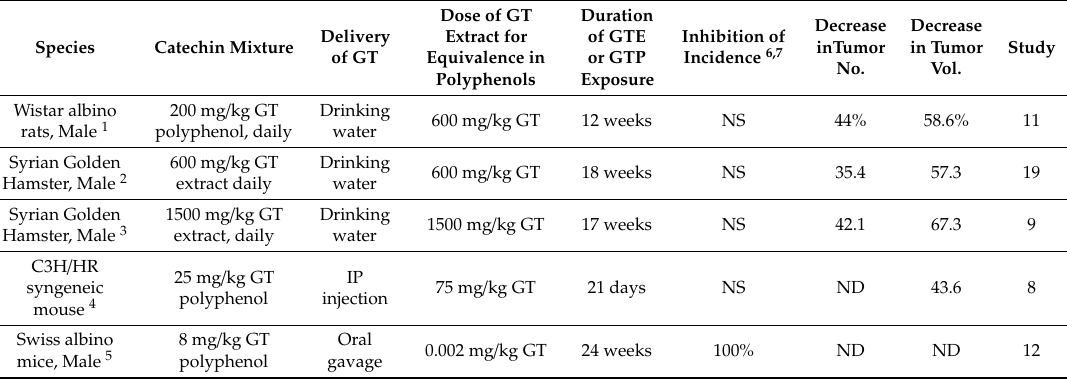
Table 1. Extract / polyphenol e ff ects on rodent oral squamous cell carcinoma models.